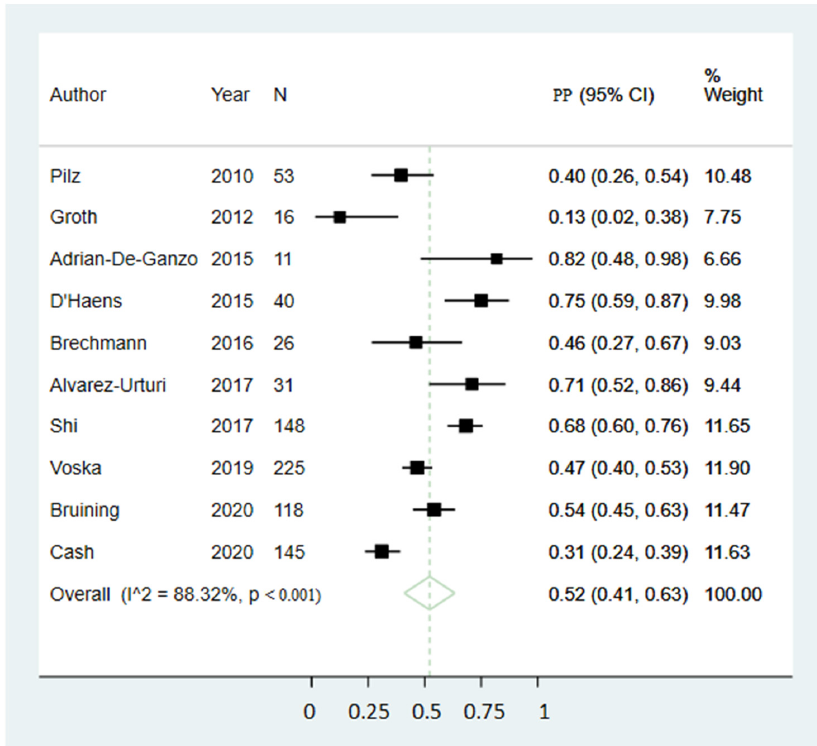
Figure 2. Pooled estimate of CCE preference proportion. Abbreviations: CI, confidence interval; PP, Estimated preference proportion.